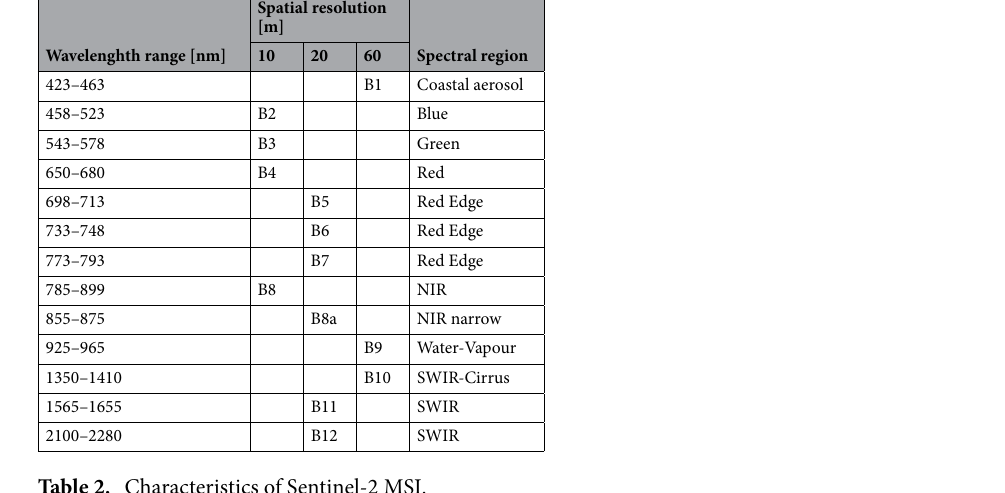
Table 2. Characteristics of Sentinel-2